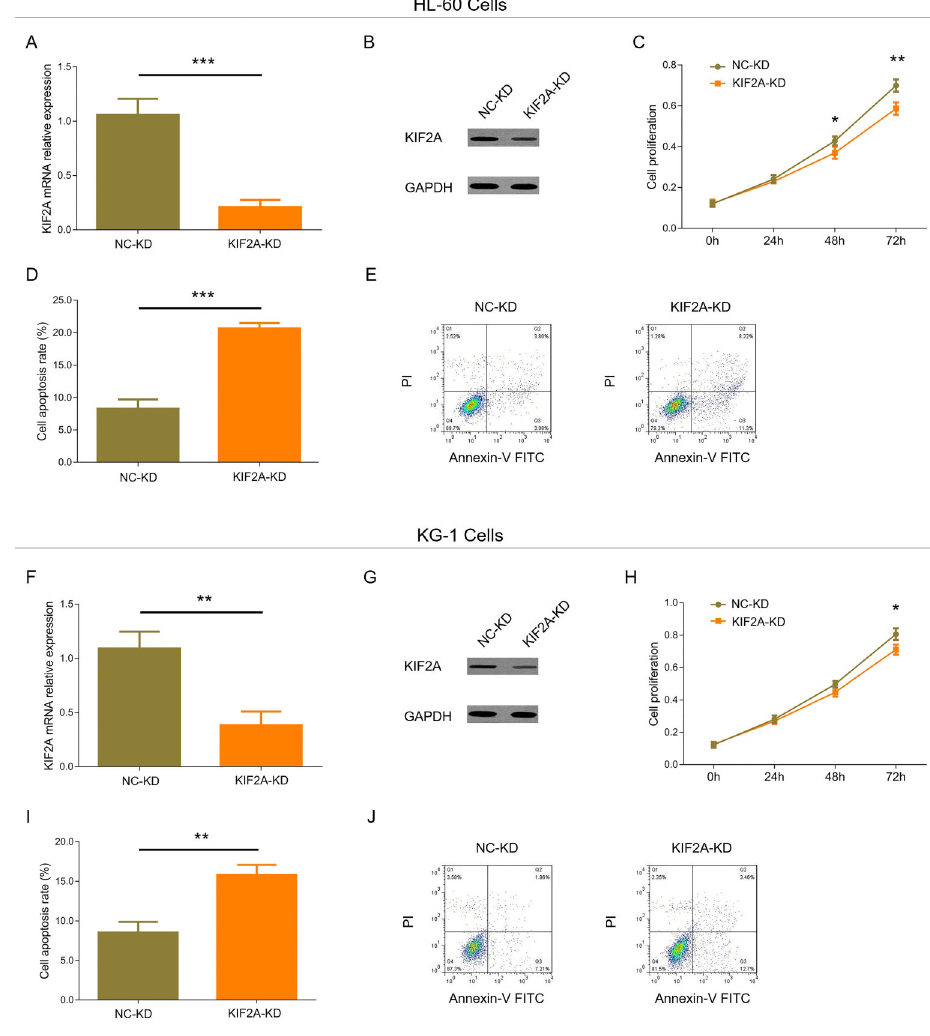
Figure 5. RT-qPCR and CCK-8 experiments were carried out in triplicate, and western blot was performed once. A , KIF2A mRNA, B , protein expression, C , cell proliferation, and D and E , cell apoptosis in the KIF2A-KD group and the negative control (NC)-KD group in HL-60 cells. F , KIF2A mRNA, G , protein expression, H , cell proliferation, and I and J , cell apoptosis in the KIF2A-KD group and the NC-KD group in KG-1 cells. Data are reported as means ± SD. *P o 0.05, **P o 0.01, ***P o 0.001 (independent samples t -test). KIF2A: kinesin family member 2A; KD: knockdown; GAPDH: glyceraldehyde-3-phosphate dehydrogenase; FITC: fl uorescein isothiocyanate; PI: propidium